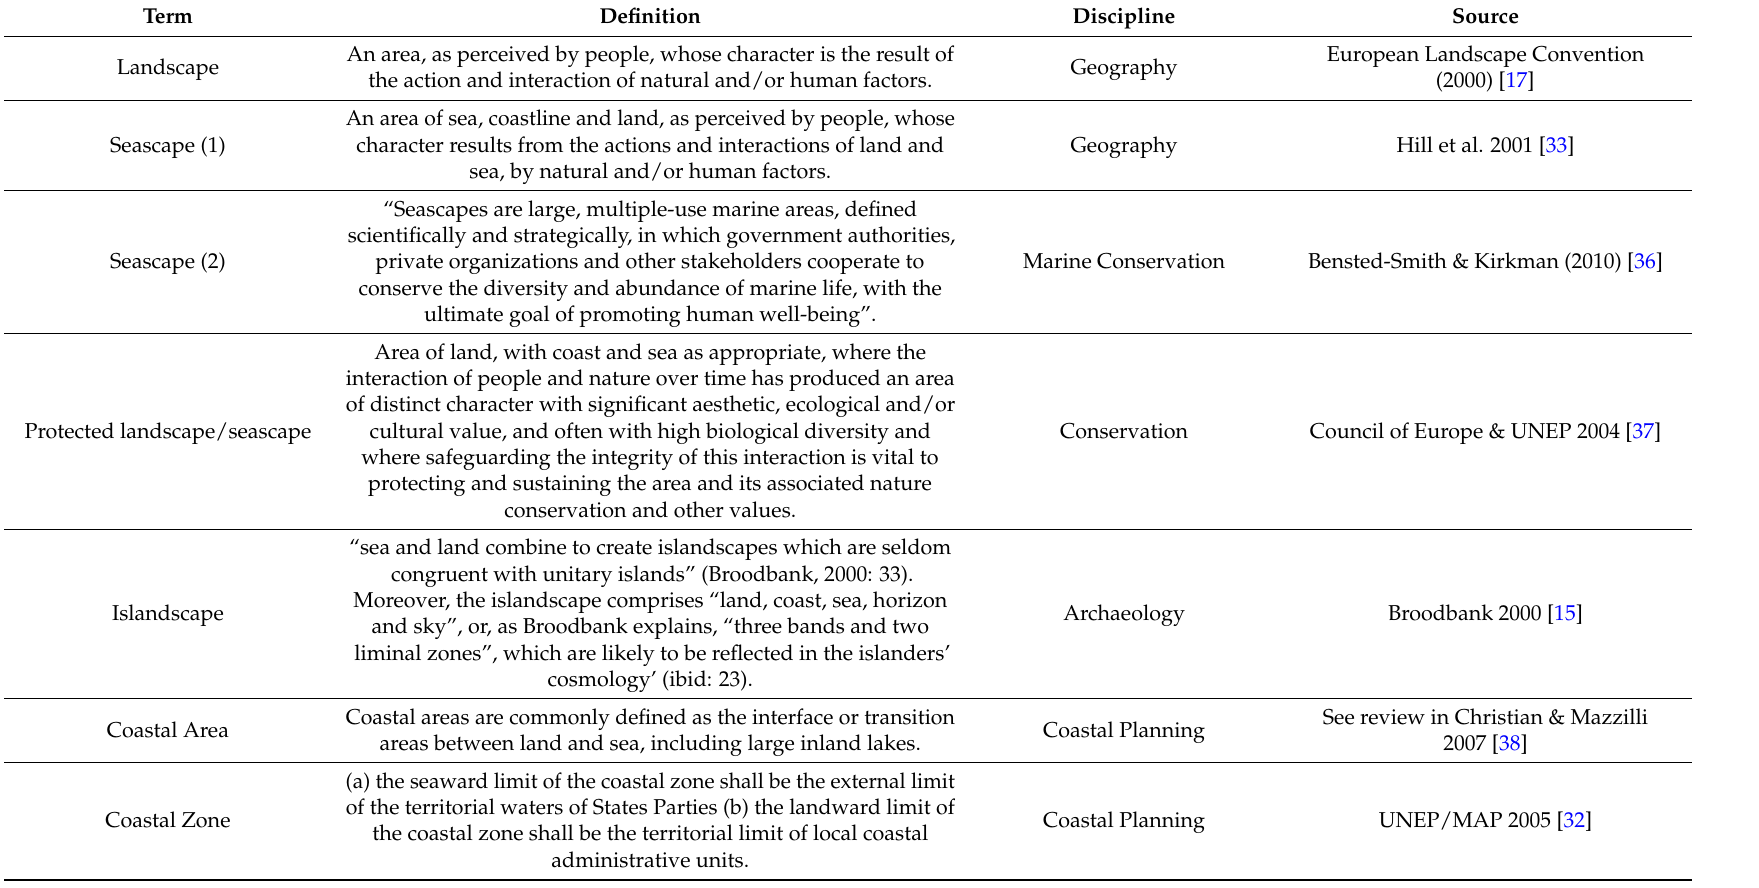
Table 3. Common terms used in the text and their